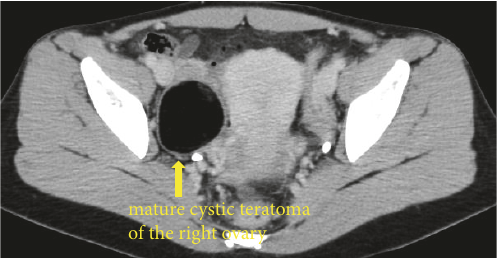
Figure 1: Contrast-enhanced computed tomography image of the pelvic cavity.